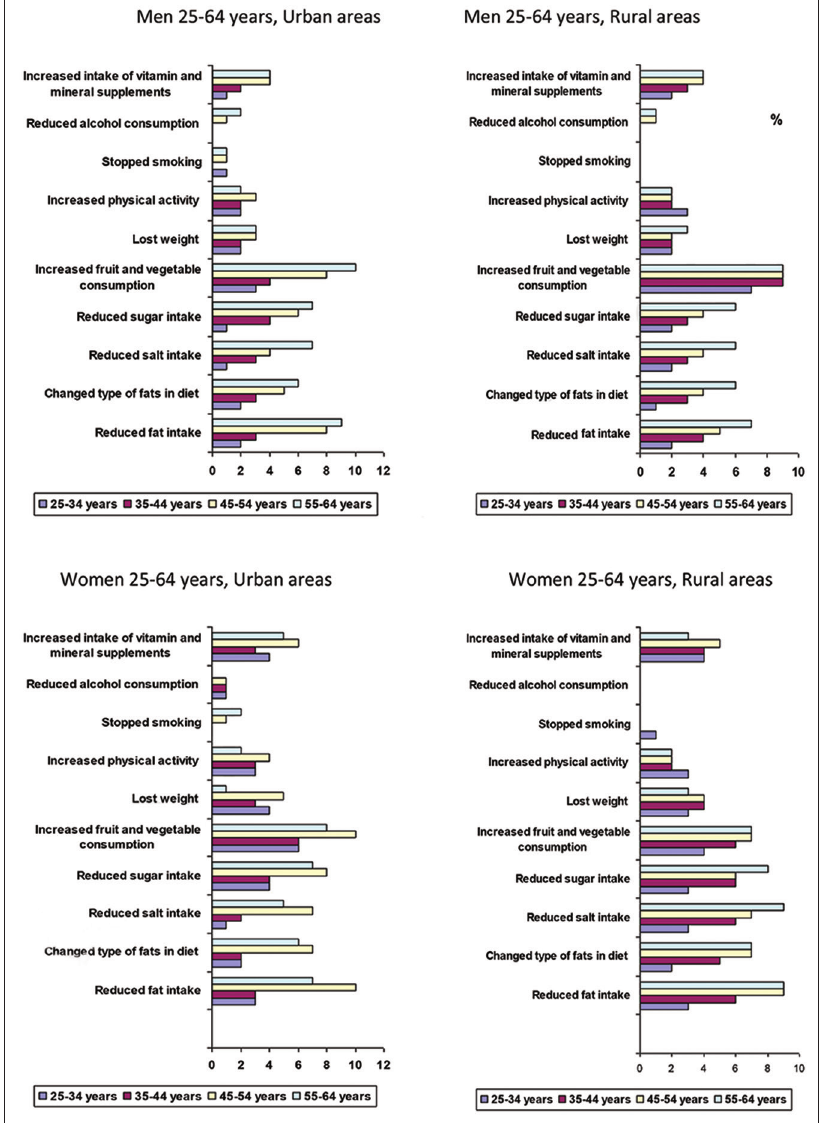
Figure 1. Prevalence of changes in behavior according to the area, age and sex, urban/rural